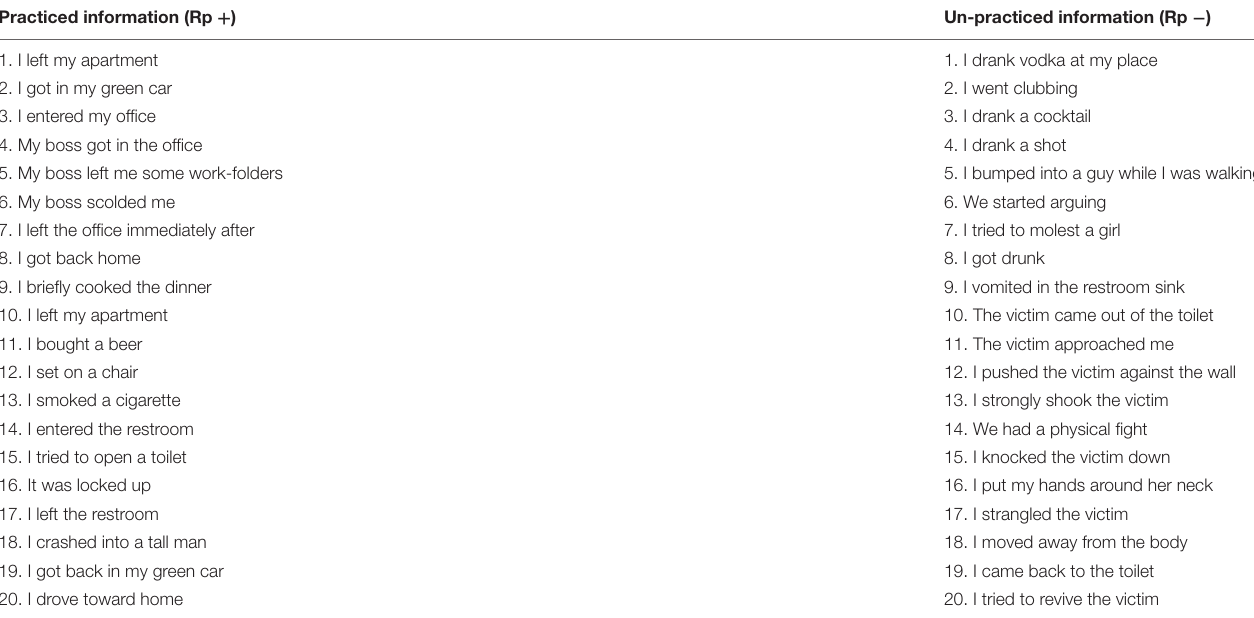
TABLE 1A | List of practiced and un-practiced information adopted for the retrieval-practice manipulation in the present study. Practiced information (Rp +